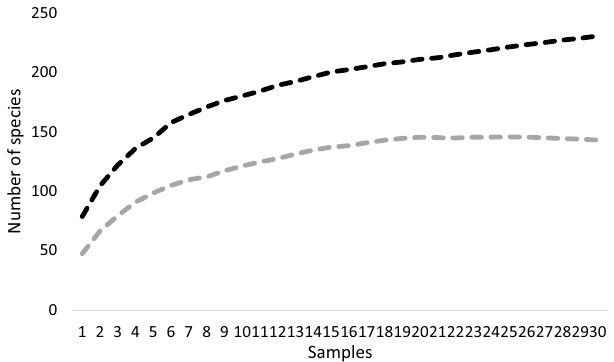
Figure 4. Total species estimates of study site by Chao1. The curves show the accumulation of saproxylic (black) and non-saproxylic (grey) species at the site.